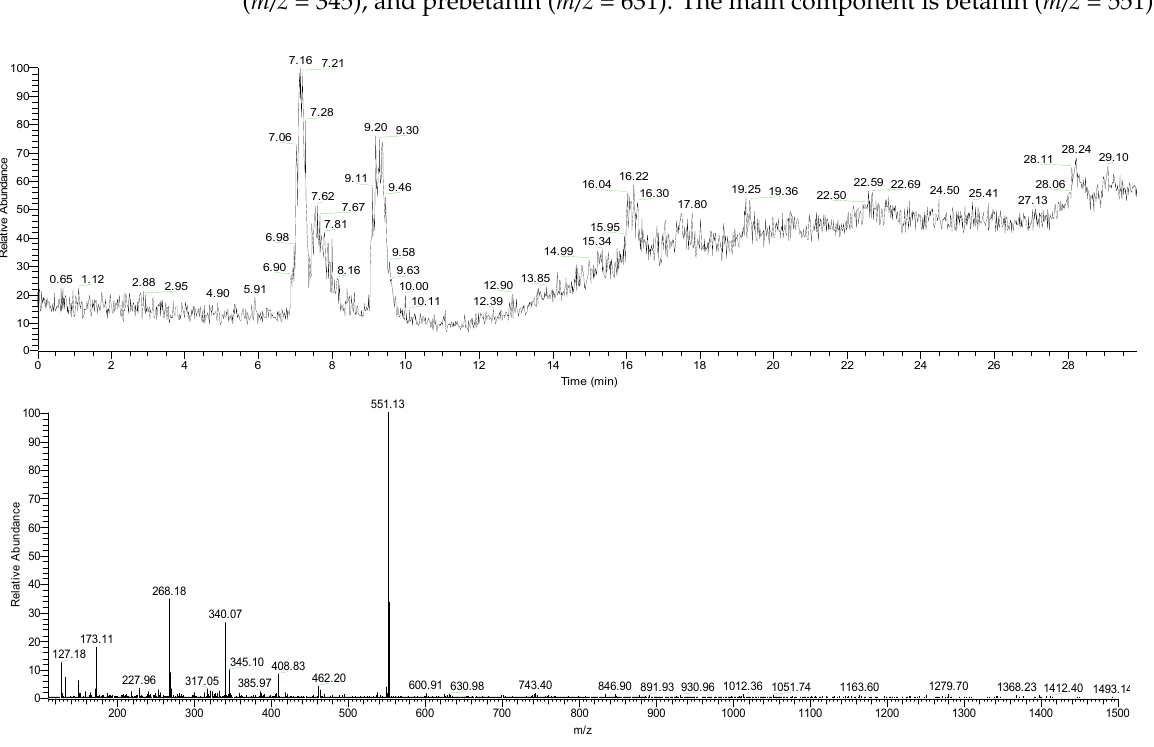
Figure 3. HPLC chromatogram of the betalains compound identified in the red beet peel extract.